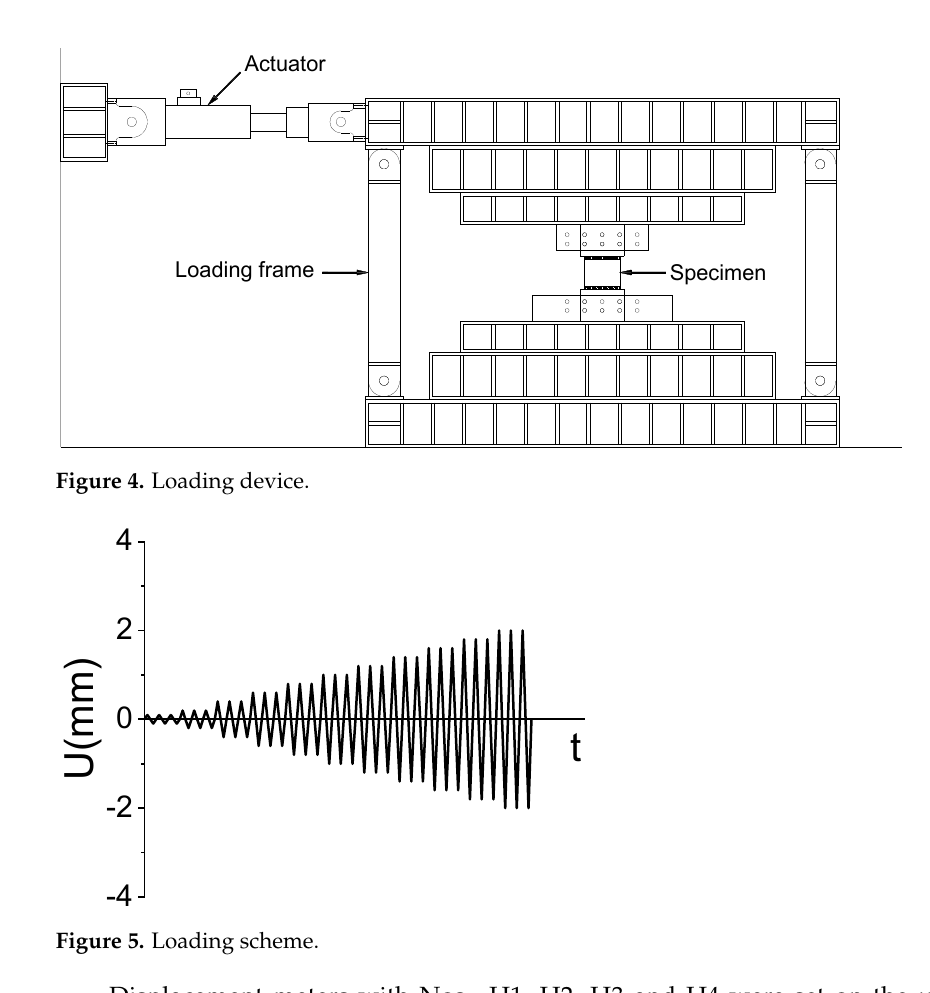
Figure 6. Measurement scheme.